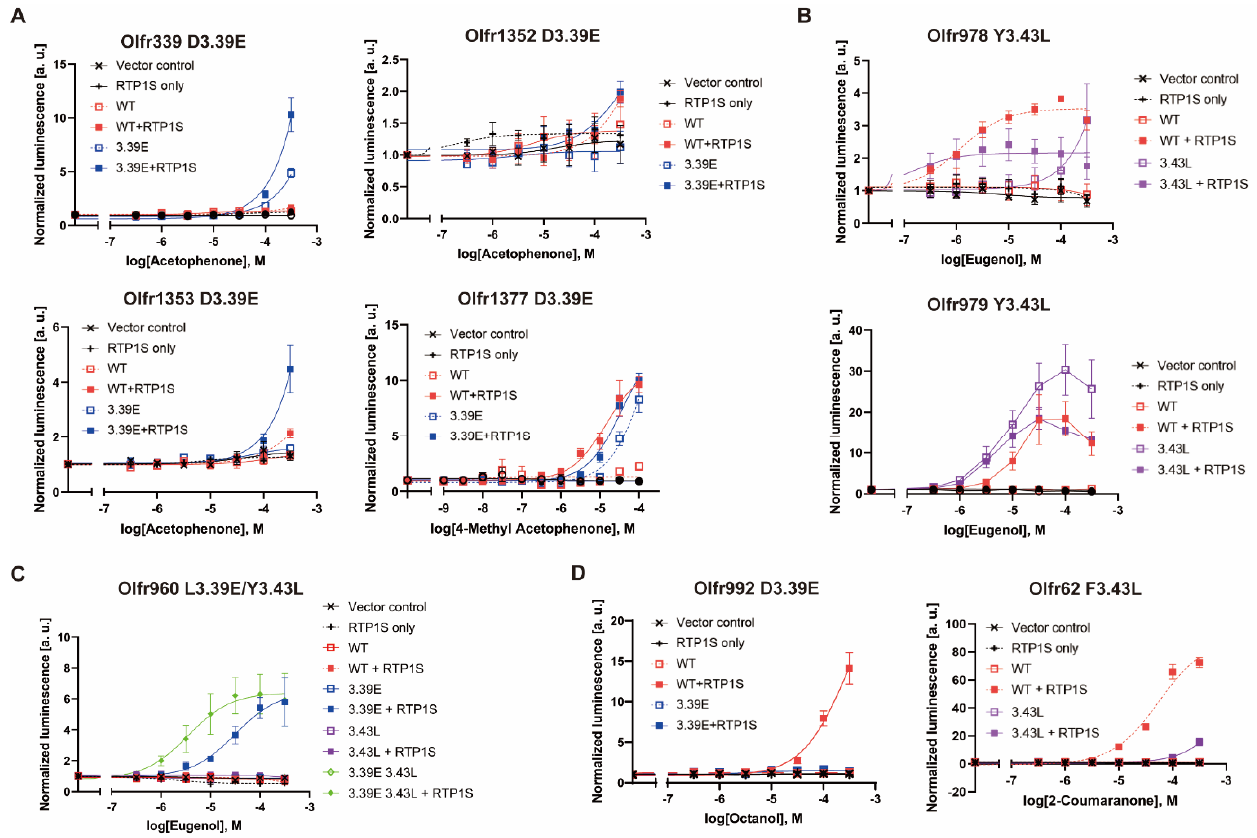
Figure 4. Dose-response curve of each mouse OR mutant. ( A ) D3.39E mutants of Olfr339, Olfr1352, Olfr1353 and Olfr1377, ( B ) Y3.43L mutants of Olfr978 and Olfr979, ( C ) Olfr960 L3.39E, Y3.43L and double mutants, ( D ) ORs with reduced agonist response due to mutations. Olfr992D3.39E against octanol and Olfr62F3.43L against 2-coumaranone. All constructs, including the vector control, were also tested under RTP1S co-expression conditions. Error bars indicate s.e.m (n = 3). 2.5. The Change in Conserved E3.39 and L3.43 Caused a Loss of Function